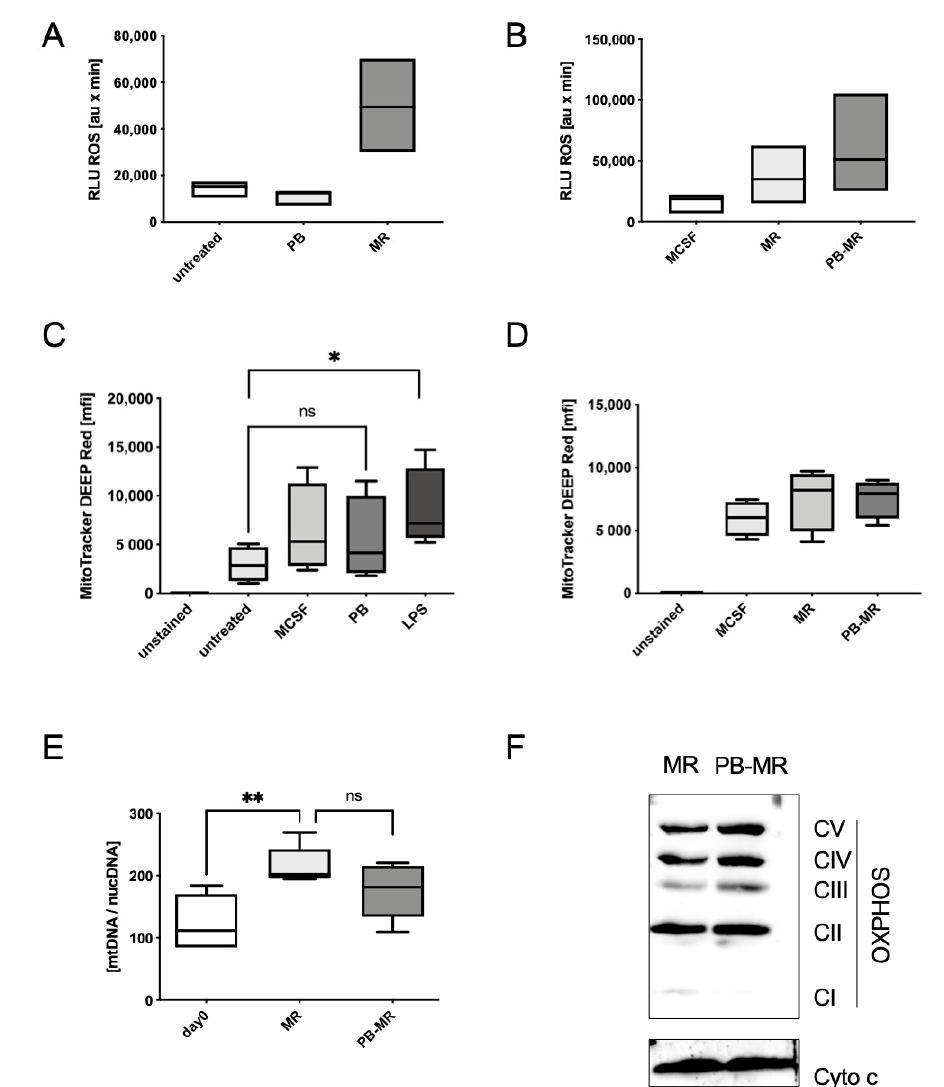
Figure 5. Plumbagin impacts ROS production in the presence of M-CSF/RANKL in BMDMs: ( A ) cells were incubated for 48 h with plumbagin or treated with M-CSF/RANKL before ROS production was analysed in a (iso)luminol-based assay ( n = 3); ( B ) cells were incubated for 24 h with M-CSF/RANKL, plumbagin or pre-treated with plumbagin before the addition of M- CSF/RANKL and ROS production was analysed in a (iso)luminol based assay on day 2 ( n = 3); ( C ) BMDMs were incubated for 6 h, as indicated. Mitochondrial activity was measured using Mitotracker deep red stain for 30 min before FACS analysis ( n = 4); ( D ) BMDMs were pre-treated for 24 h with plumbagin before the addition of M-CSF/RANKL, or treated with only M-CSF and M-CSF/RANKL, respectively. Mitochondrial activity was measured using Mitotracker deep red stain for 30 min before FACS analysis ( n = 4); ( E ) BMDMs were differentiated as indicated and the mitochondrial copy number was determined by comparing mitochondrial and nuclear DNA levels ( n = 5); ( F ) the expression of OxPhos components was analysed in the mitochondrial extracts from cells treated with M-CSF/RANKL or plumbagin pre-stimulated (PB-M/R) cells by Western blot analysis on day 3. The blot is one typical example out of 3 experiments. Statistical analysis was performed comparing the results to the untreated control for ( C ) and for ( F ) to the day 0 or positive control (M-CSF/RANKL) using a Mann–Whitney test. *: p ≤ 0.05; **: p ≤ 0.01. ns. p >